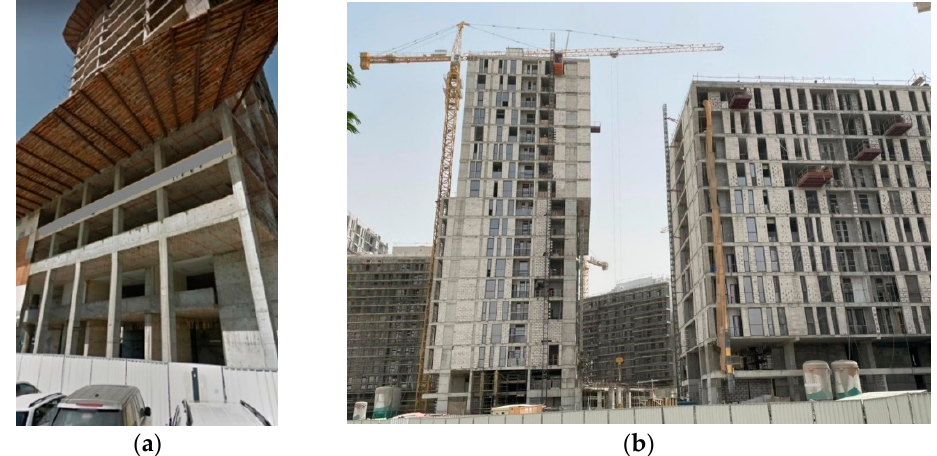
Figure 2. ( a ) High-rise buildings under construction in Sharjah [own materials]. ( b ) High-rise build- ings under construction in Sharjah [own materials].